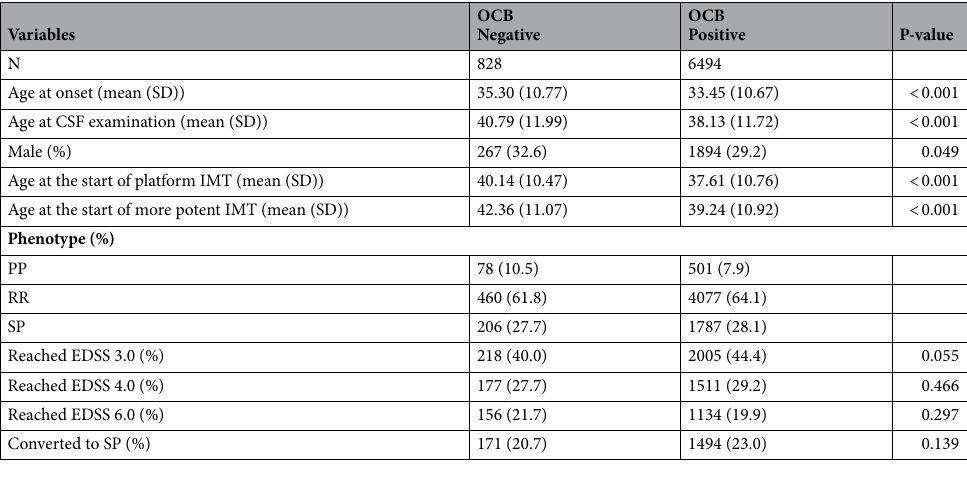
Table 1. Clinicodemographic data of study population, stratified by OCB. SD standard deviation, CSF cerebrospinal fluid, IMT disease modifying treatment, PP primary progressive, RR relapsing remitting, SP secondary progressive, EDSS expanded disability status